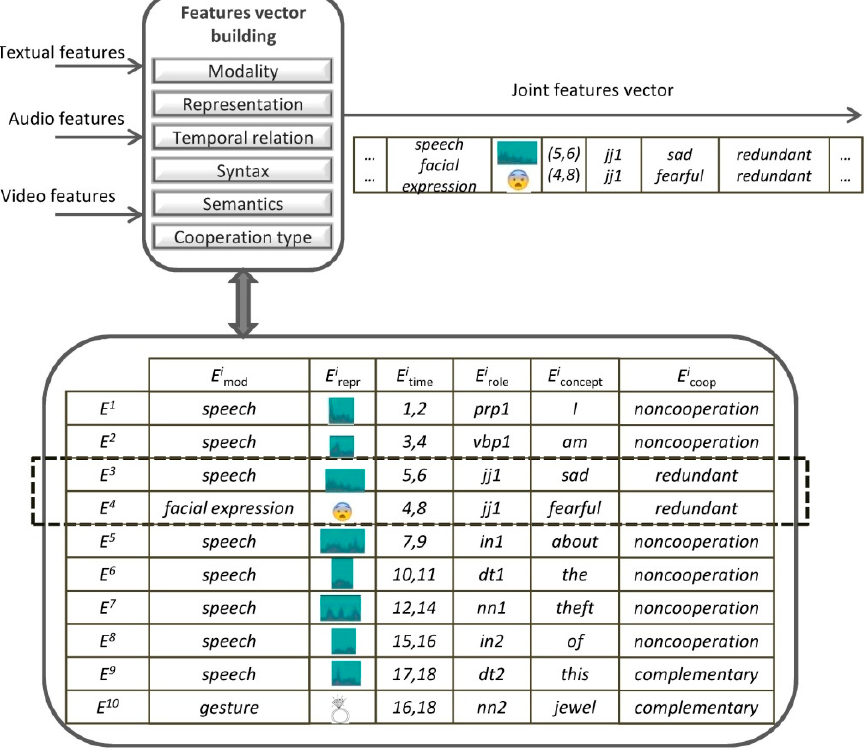
Figure 3. Process of building the joint features vector.